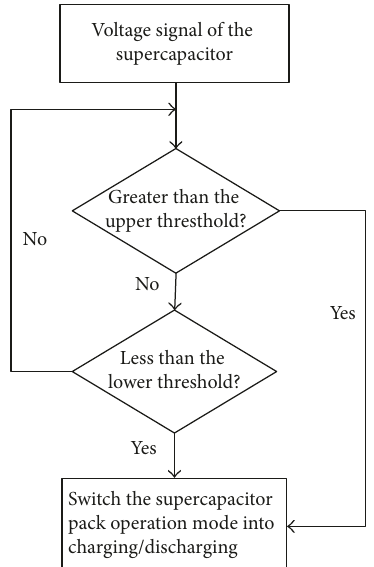
Figure 6: The switching logic of supercapacitor operation mode.